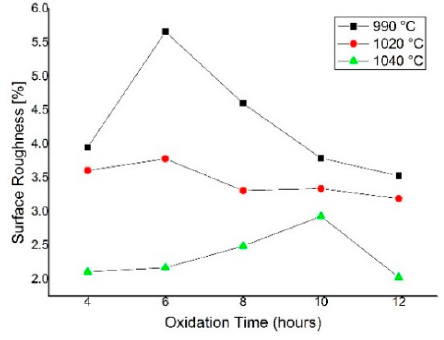
Figure 7. Surface roughness of oxide layer for various process temperature.